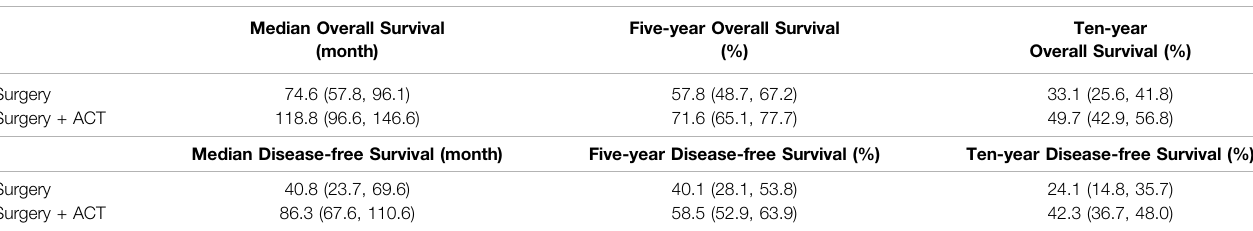
ACT, indicates adjuvant